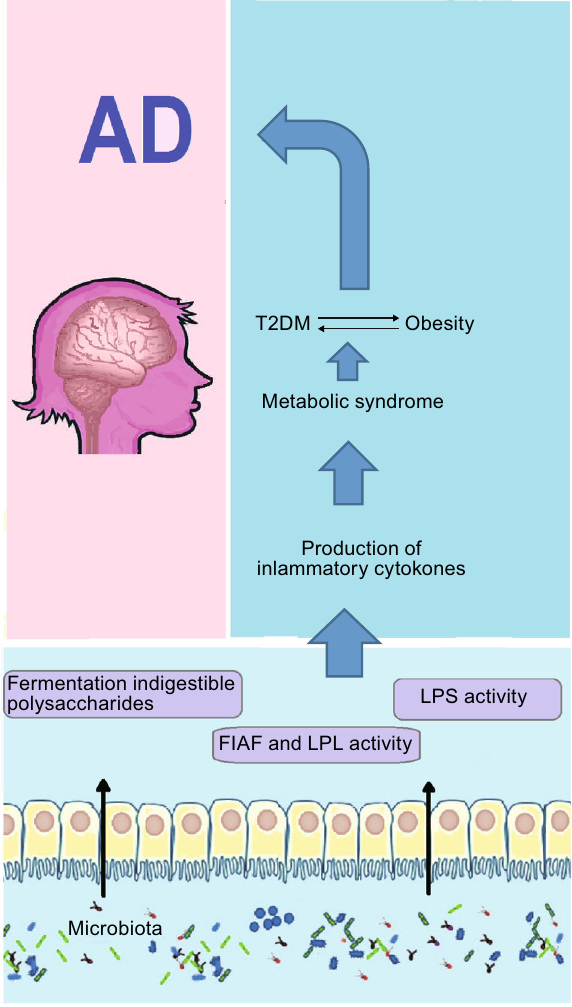
Figure 2. The links between gut microbiota and metabolic diseases, as obesity and further develop- ment of T2DM with AD. FIAF: fasting-induced adipocyte factor; LPS: lipopolysaccharide; LPL: lipoprotein lipase; T2DM: type 2 diabetes mellitus; AD: Alzheimer ’